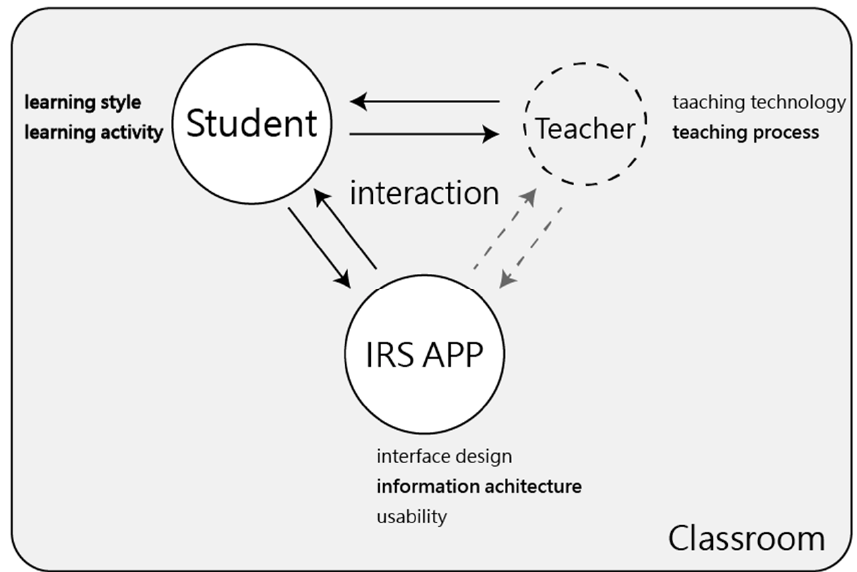
Figure 1. Research framework.